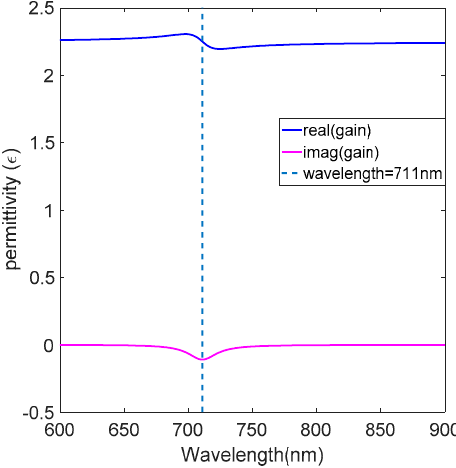
Figure 2. The relative permittivity of the gain − doped medium.